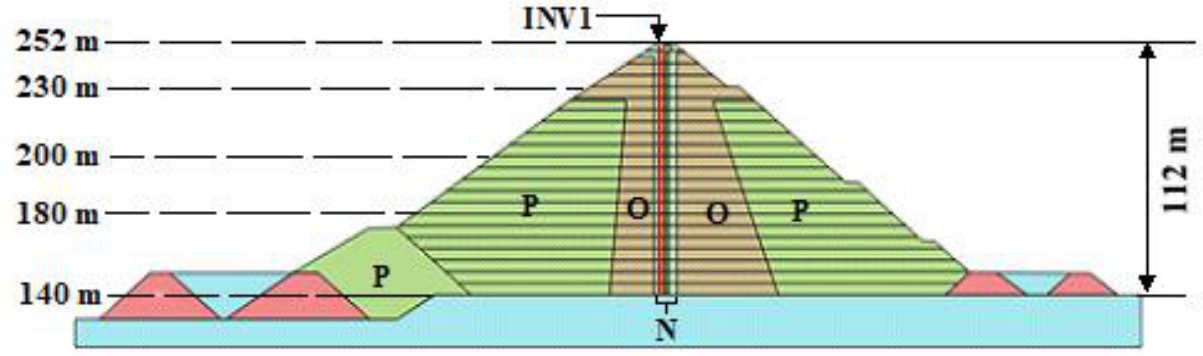
Figure 1. 2D cross-section model of the Romaine-2 dam in Plaxis. Different zones of the dam are highlighted by letters. The vertical inclinometer INV1 is found in section PM560.